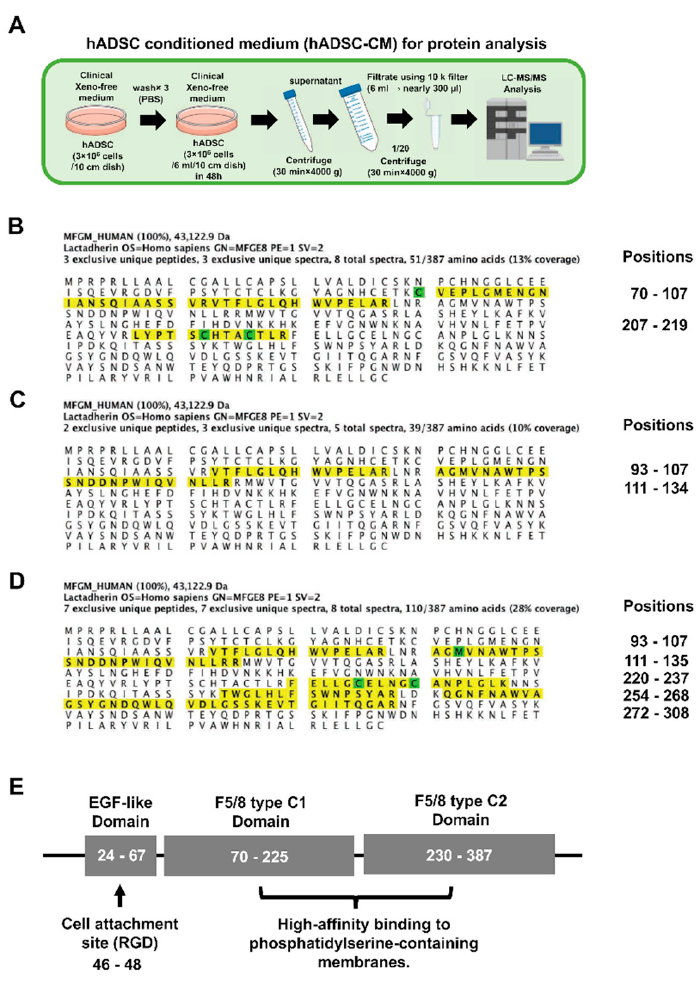
Figure 4. Illustration of the preparation of conditional medium for hADSC and the detection of the peptide sequence in the full length of the protein amino acid sequence is shown. The procedure for preparing the hADSC-CM concentrate for the LC–MS/MS analysis ( A ); The amino acid sequence of MFG-E8 detected in the hADSC-CM sample by the LC–MS/MS analysis is indicated with a yellow marker. The positions of the detected peptides are shown on the right side of the panel. The green marker of the amino acid sequence indicates the modified (C; Carbamidomethyl) amino acid base ( B ); The amino acid sequence of MFG-E8, which was detected in the hADSC (CDM) sample by the LC–MS/MS analysis, is indicated with a yellow marker. The positions of the detected peptides are shown on the right side of the panel ( C ); The amino acid sequence of MFG-E8, which was detected in the hADSC (DMEM-10% FBS) sample by the LC–MS/MS analysis, is indicated with a yellow marker. The positions of the detected peptides are shown on the right side of the panel. The green marker of the amino acid sequence indicates the modified (C; Carbamidomethyl, M; Oxidation) amino acid base ( D ); Illustration of the domain site of human MFG-E8 protein ( E